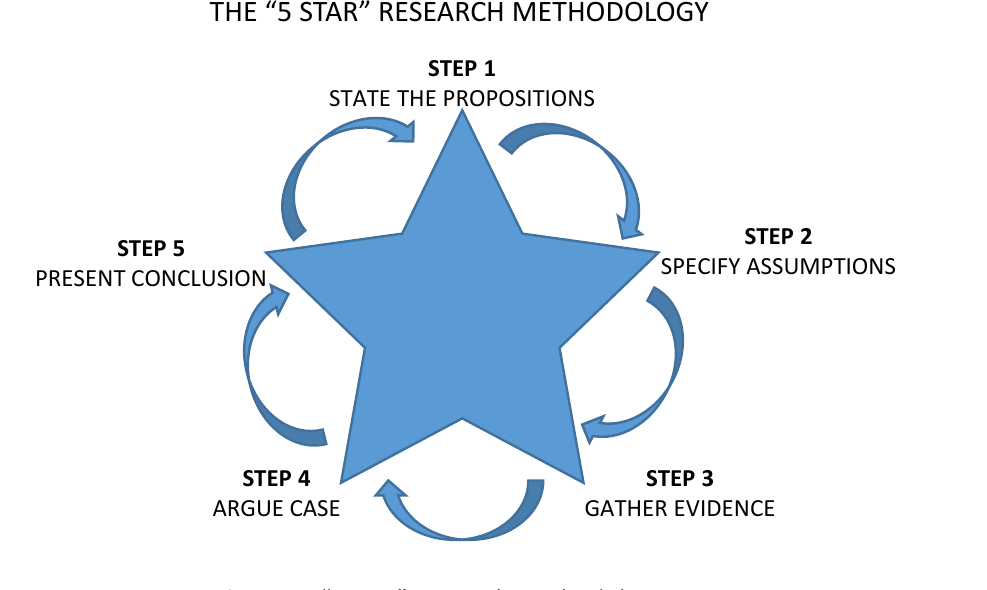
Figure 1. “5 Star” research